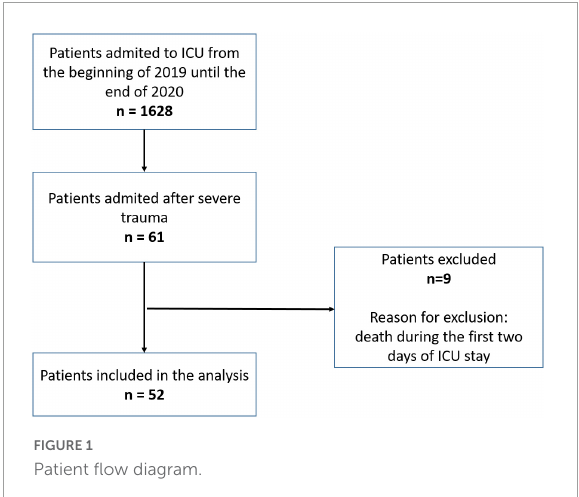
FIGURE1 Patient flow